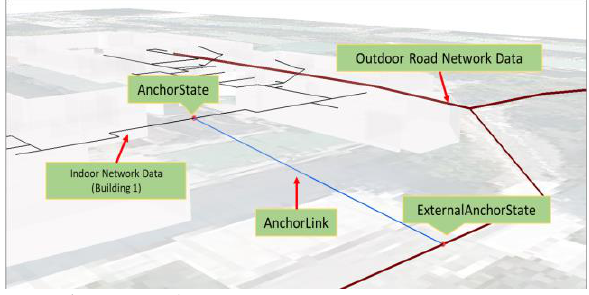
Figure 6 . Defining the connecting nodes based on the SeamlessNavigation